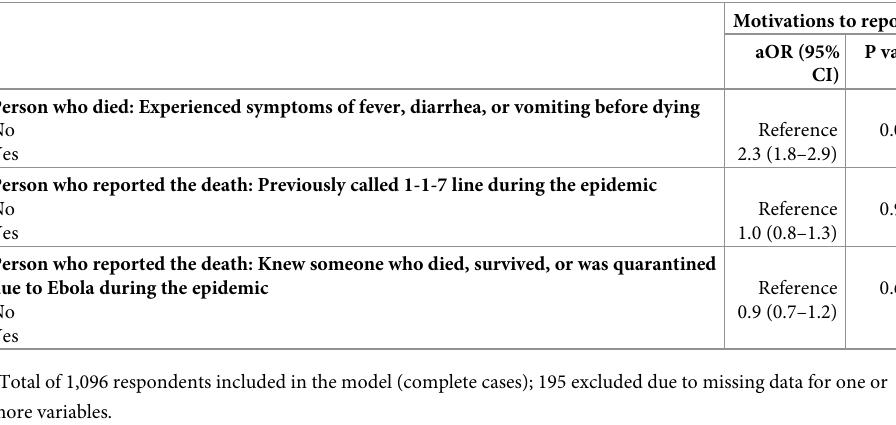
Table 4. Past Ebola experiences and Ebola-like symptoms as determinants of death reporting motivations, Sierra Leone, April